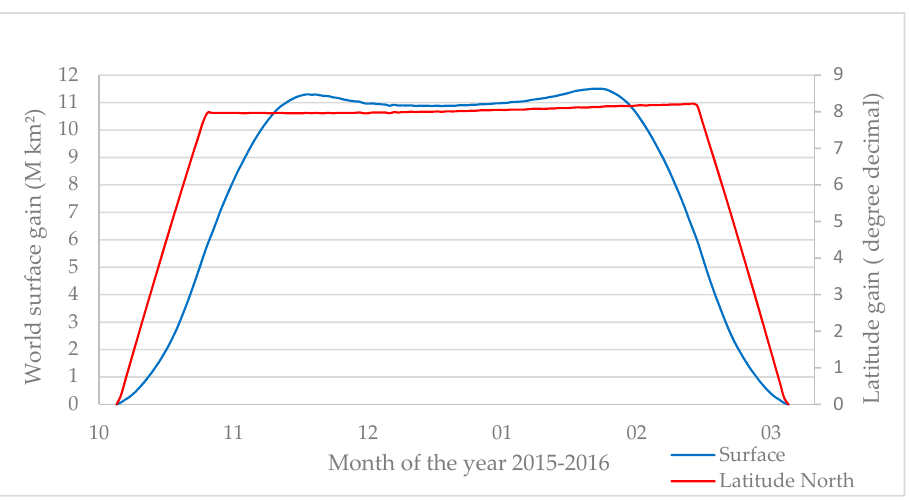
Figure 8. Evolution of the gain in terms of surface (blue) and decimal degree of latitude (red) during winter 2015–2016 due to the change from 82° to 90° sun zenith angle SZA. The asymmetry of gain for both curves is due to the equation of time.